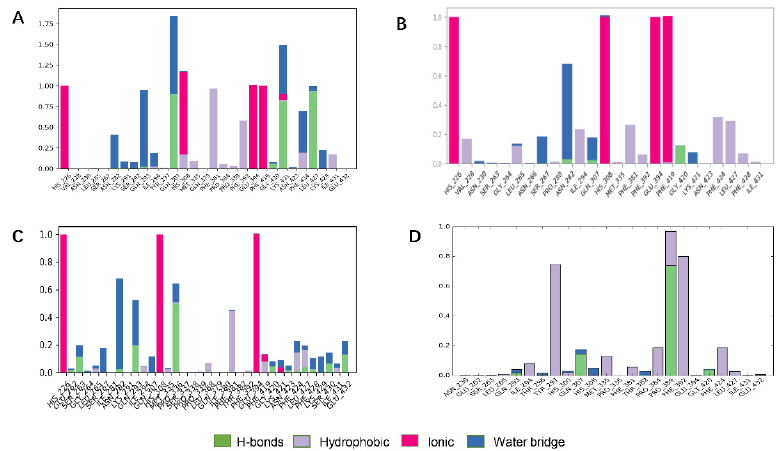
Figure 4. Bar charts of protein–ligand (P–L) contacts. ( A ) ZINC000049180836 ( B ) ZINC000040310216, ( C ) ZINC000003830381, ( D ) ZINC000002032320. Abscissa represents the amino acid number. Ordinate represents interactions fraction.